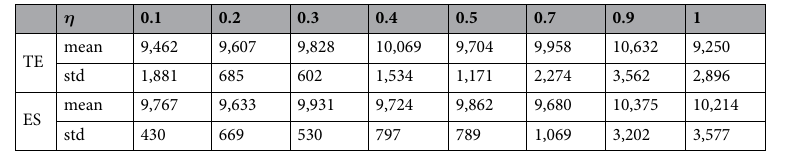
Table 2. Predicted leadership switching time (mean and standard deviation) between particle 1 and 2 as a function of the noise